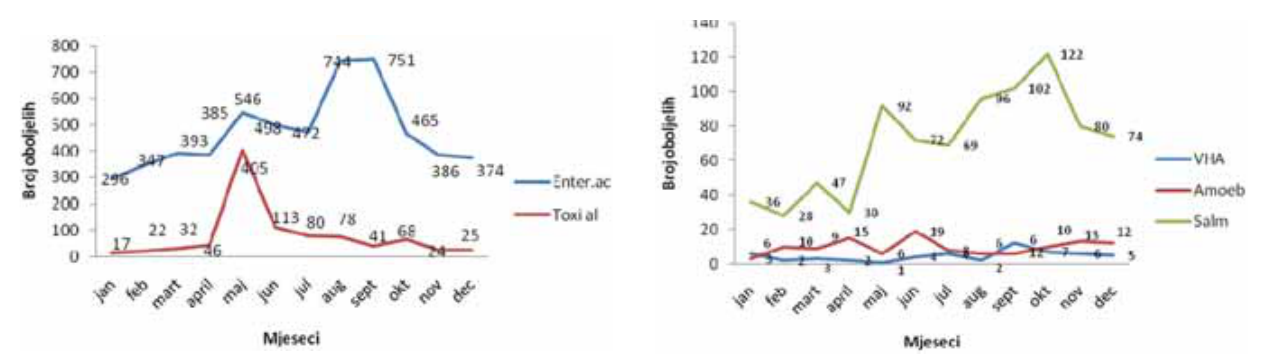
SLIKA 7. Kretanje Enterocolitis acuta i Toxiinfectio alimentaris po mjesecima posljednjih godina značajno mijenja, a što je posljedica promjena načina življenja. Prosječna incidenca je bila 455/100 000 stanovnika. Naše istraživanje je pokazalo da su enterocolitis acuta i toxiinfectio alimentaris naj- češća oboljenja, dok je VHA registrovan znatno rjeđe. U prevenciji crijevnih zaraznih oboljenja su postignuti dobri efekti primjenom “jednostavnih“ mjera kao što su: pranje ruku i edukacija o higijenskim principima osoblja koje rukuje sa hranom (11). Ipak, uprkos po- boljšanju higijensko-sanitarnih uslova, evidentan je porast broja oboljelih od ovih oboljenja, a što je poslje- dica porasta industrijske proizvodnje hrane (1,12). Po- sebno velike promjene su u epidemiologija hepatitisa A.